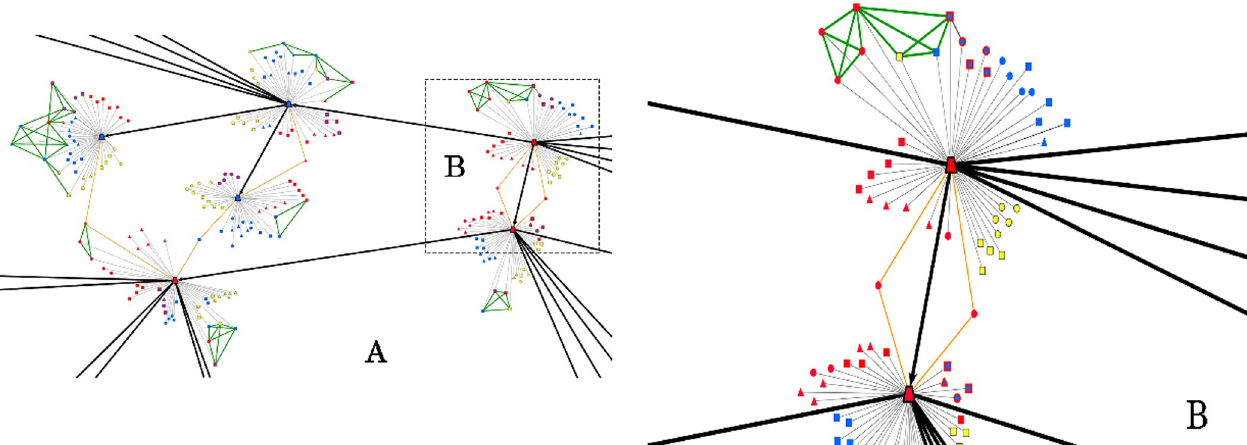
Fig 2. Multi-layered network ( the network of networks ) built by the link-tracing sampling method. (A) Inter-connected personal networks, through link- tracing ties and shared alters. (B) Zoom in on the personal network of respondents (the dotted area of A in the panel). Node colors designate places (countries) wherein individuals currently live, i . e ., ‘blue’ for Daˆmbovi ț a (Romania), ‘red” for Castello´n (Spain), ‘yellow’ for other places than Daˆmbovi ț a and Castello´n (these other places could be other regions in Romania and Spain, or even other countries–for simplicity and illustrative purposes, in this example, we decided, by ‘yellow’, to mark other countries. Node shapes designate classes of individuals (alters) elicited by the fixed-number alter name-generators: ‘squares’ designate ego’s family members , ‘triangles’ designate ego’s friends , while ‘circles’ designate ego’s acquaintances . The ego (the respondent) is marked by a trapezoid shaped —black bordered node. Ego’s alters (family members, friends and acquaintances) who lived in Castello´n (Spain) and returned to live in Romania are marked by ‘red’ bordered shapes ( e . g ., returned family members are marked by blue squared nodes with red border). A sub-set of nine alters was randomly sampled from the elicited set of alters, and the alter-alter existing ties represented. This is illustrated by the green edges. If two nodes are connected by an edge, that means the two nodes know each other and can contact each other independently from the ego. As all the nodes represent ego’s alters, the respondent (the trapezoid shaped node) is connected to everybody through a tie (see the thin gray edges). Orange edges indicate the cases wherein two egos share alters. The black arrows indicate the direction of the link-tracing sampling: an arrow’s origin marks the referee while the head of the arrow marks the referral. The plots were built using visone